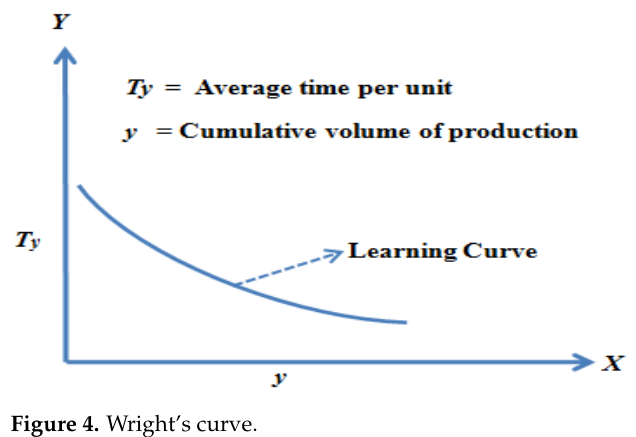
Figure 4. Wright’s Figure 4. Wright’s curve.